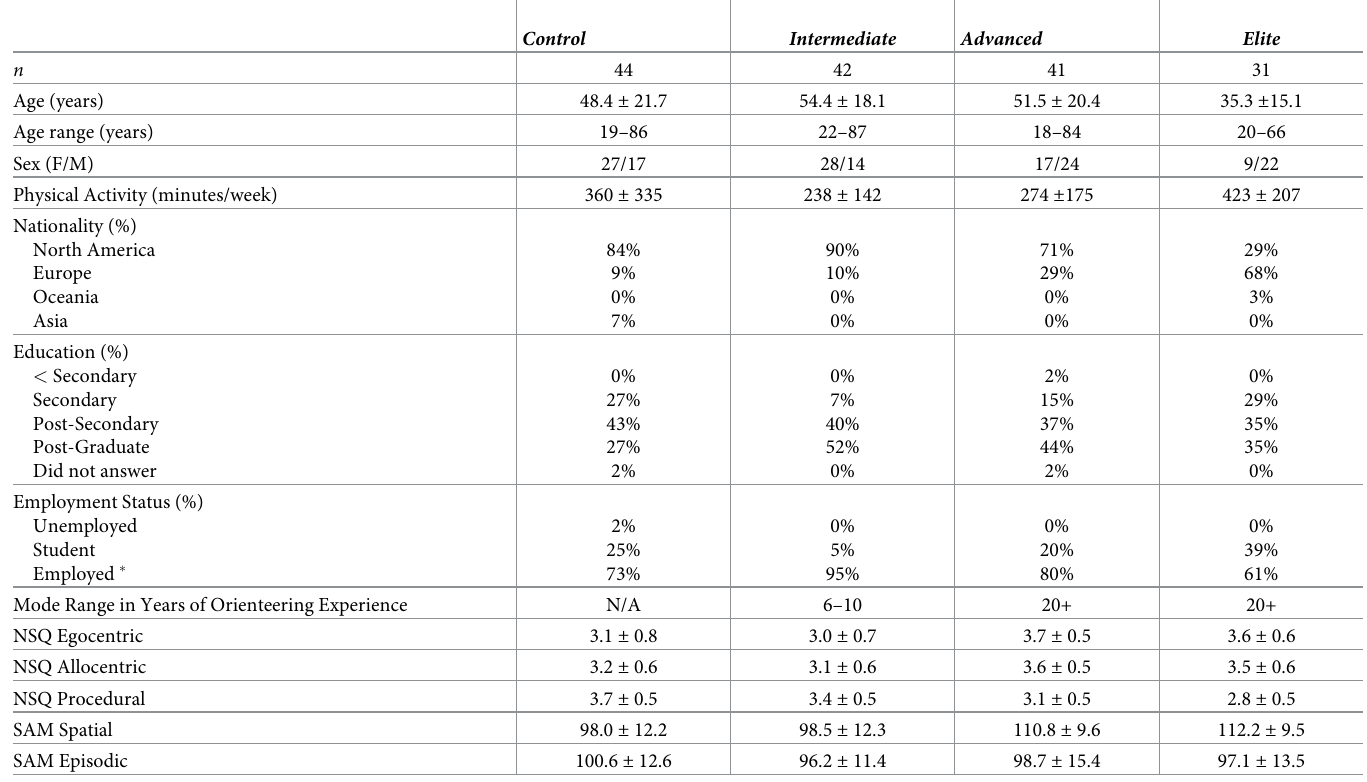
Table 1. Descriptive statistics and average outcome measures across